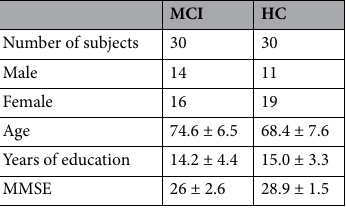
Table 4. Subject information of the NTUHV dataset (MCI vs. HC).